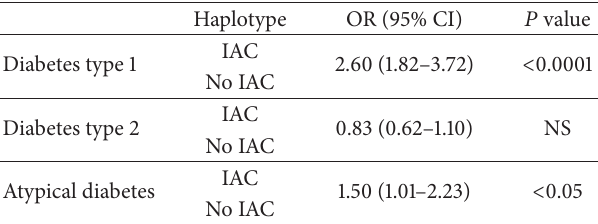
Table 4: Haplotype association with the